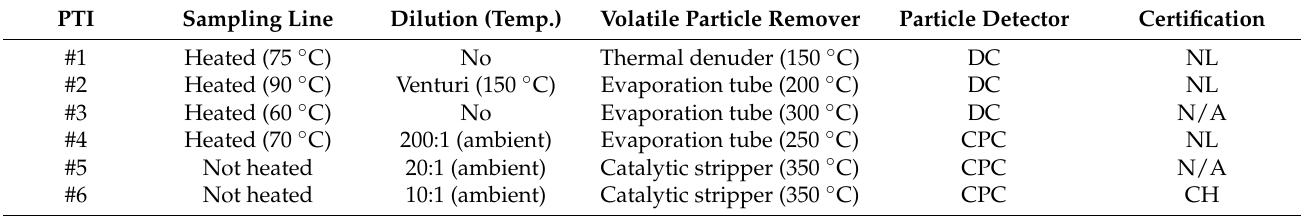
Table 1. Sampling and measurement technologies used at the PTI